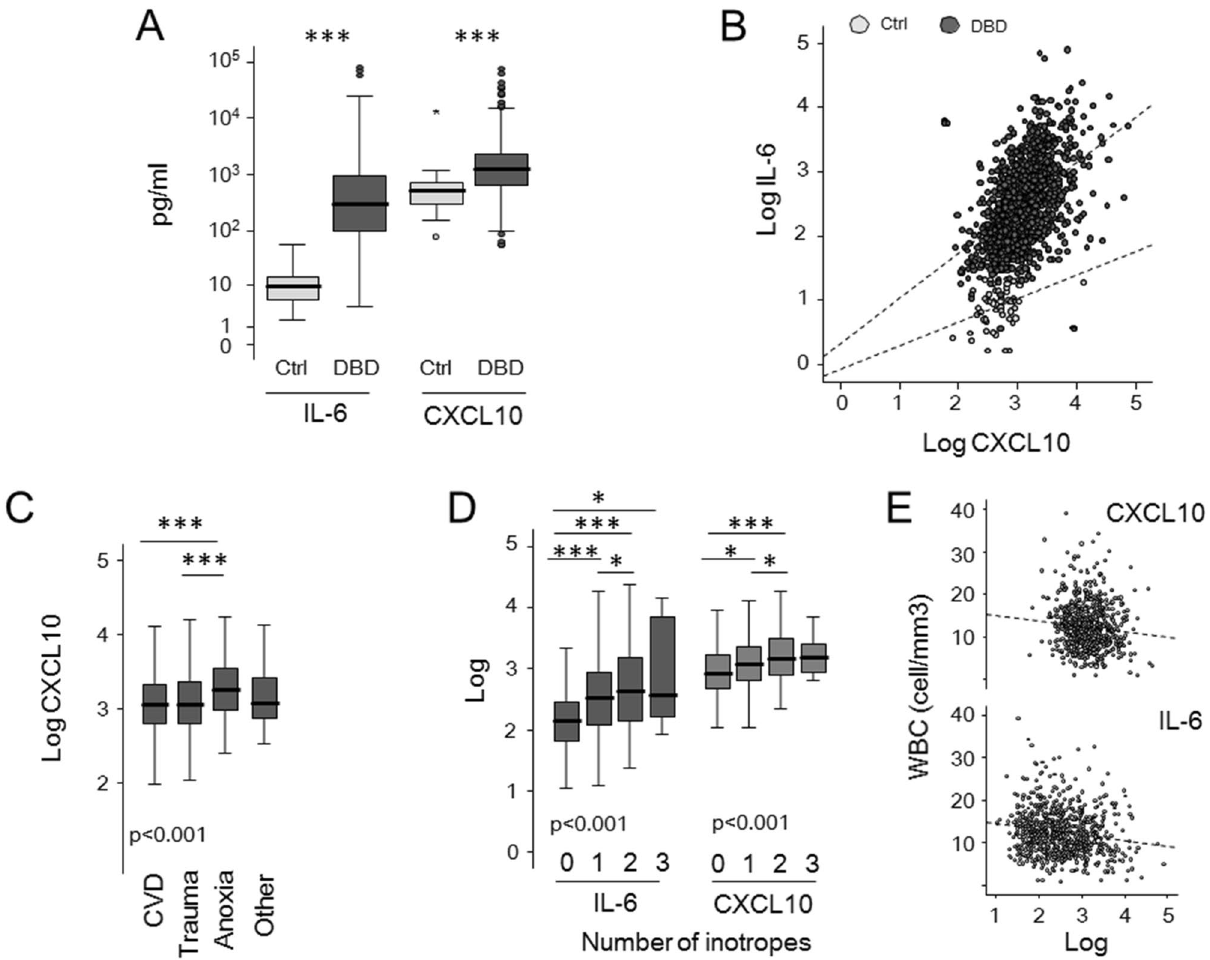
Figure 1. Circulating levels of IL-6 and CXCL10 in deceased donors and healthy subjects. ( A ) Circulating levels of IL-6 and CXCL10 in serum from healthy subjects (Ctrl, n = 55), and deceased donors (donation after brain death, DBD, n = 1100) were evaluated. The boxes represent the interquartile range, the line represents the median, and whiskers indicate the range of observed responses. *p < 0.05; **p < 0.01; ***< 0.001; Mann–Whitney U test. ( B ) Scatter plot illustrating the relationship between IL-6 and CXCL10. ( C , D ) Circulating levels of IL-6 and CXCL10 according to death cause and number of donor inotropes. The boxes represent the interquartile range, the line represents the median, and whiskers indicate the range of observed responses. P value was calculated by Kruskal–Wallis test; *< 0.05; ** p< 0.01; *** p< 0.001 at post-hoc analyses by Mann–Whitney U tests, p value adjusted for the number of comparisons done. ( E ) Scatter plot illustrating the relationship between IL-6, CXCL10 and white blood cell transformation and as binary variables (see “Method”***). In addition to the two cytokines, the following vari- ables were included in the model: donor sex and age, recipient sex and age, donor cause of death (cardiovascu- lar accident, trauma), donor characteristics (ICU stay, diabetes, hypertension, hypotension, cardiac arrest, cold ischemia time), donor inotrope administered (none, one, two or more), time spent on the waiting list, number of HLA mismatches (HLA-A, -B, and -DR antigens), maximum panel-reactive antibody (PRA) level, immunologic risk and NITK3 38 (for kidney transplant only). The level of function of a graft in the immediate postoperative period was described to be correlated with long-term graft and patient survival. Confirming what is expected, even in our cohort the absence of IGF in the postoperative period was correlated with graft and recipient survival (Supplementary Figure S2): hazard ratios for graft failure were 3.1 (2.2–4.5; p < 0.001), 13 (8.4–20.2, p < 0.001) and 6.1 (3–13, p < 0.001) for kidney, liver and heart transplants, respectively. Concordantly, hazard ratios for recipient death were 1.6 (1.2–2.4, p = 0.049), 4.8 (2.9–8, p < 0.001) and 3.2 (1.7–5.9, p < 0.001) for kidney, liver and heart transplants, respectively. In the univariate analysis, we found a negative association between IL-6 or CXCL10 donor concentrations and IGF in kidney, heart but not liver recipients (Fig. 2). The multivariate analysis confirmed CXCL10 donor concentration as independent negative predictors of IGF in kidney recipient (Table 2) and IL-6 at the limit of the significance. Concordantly, high CXCL10 [OR 0.58 (0.4–0.84); p = 0.004] and high IL-6/CXCL10 [OR 0.59 (0.39–0.87); p = 0.011] categories were significantly associated with lower probability of immediate kidney function, while high IL-6 category showed a weak trend [OR 0.75 (0.51–1.09); p = 0.131]. In